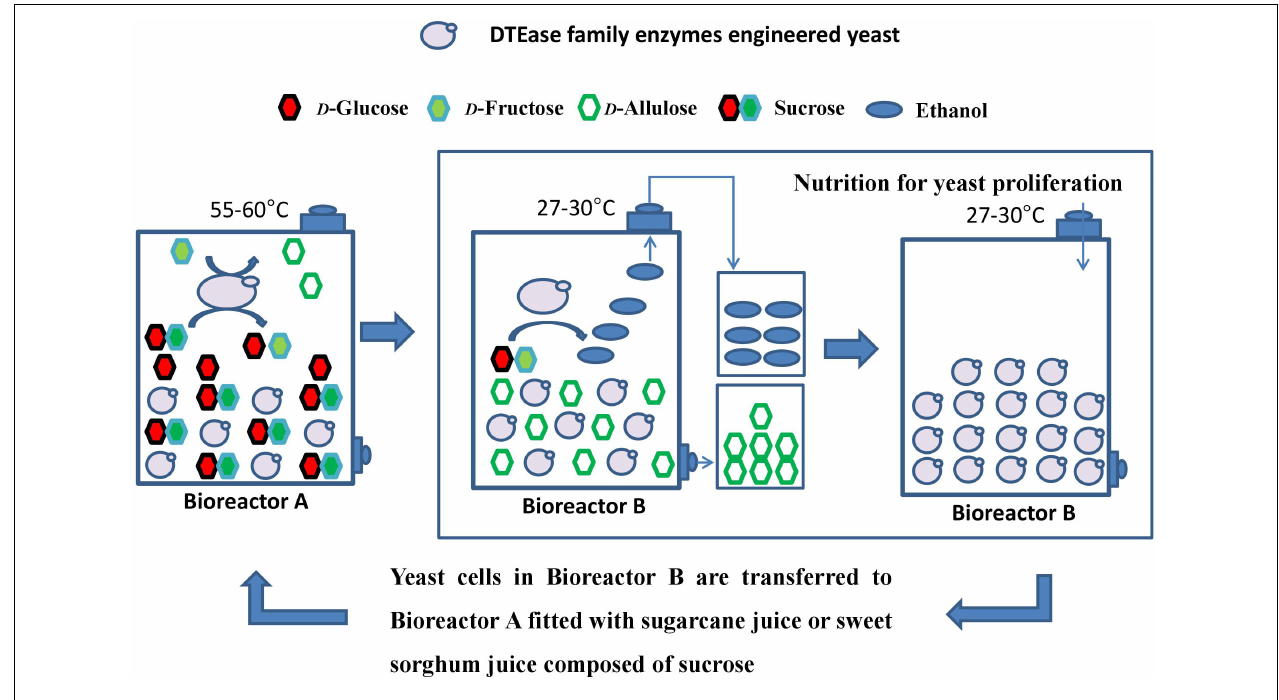
FIGURE 1 | Recycling process for D -allulose conversion and ethanol production by using sugarcane juice or sweet sorghum juice as materials. During catalysis at a high temperature of 55–60 ◦ C for 1–2 h in Reaction A, most of the yeast can’t stand such high temperature and die. A small number of yeast spores still survive. These surviving yeast spores proliferate and consume D -fructose and D -glucose to produce ethanol at a later lower temperature of 27–30 ◦ C in Reaction B. Besides, a small part of D -fructose was metabolized by the remaining living yeast at such high temperature, but most of D -fructose was still converted into D -allulose in Reaction